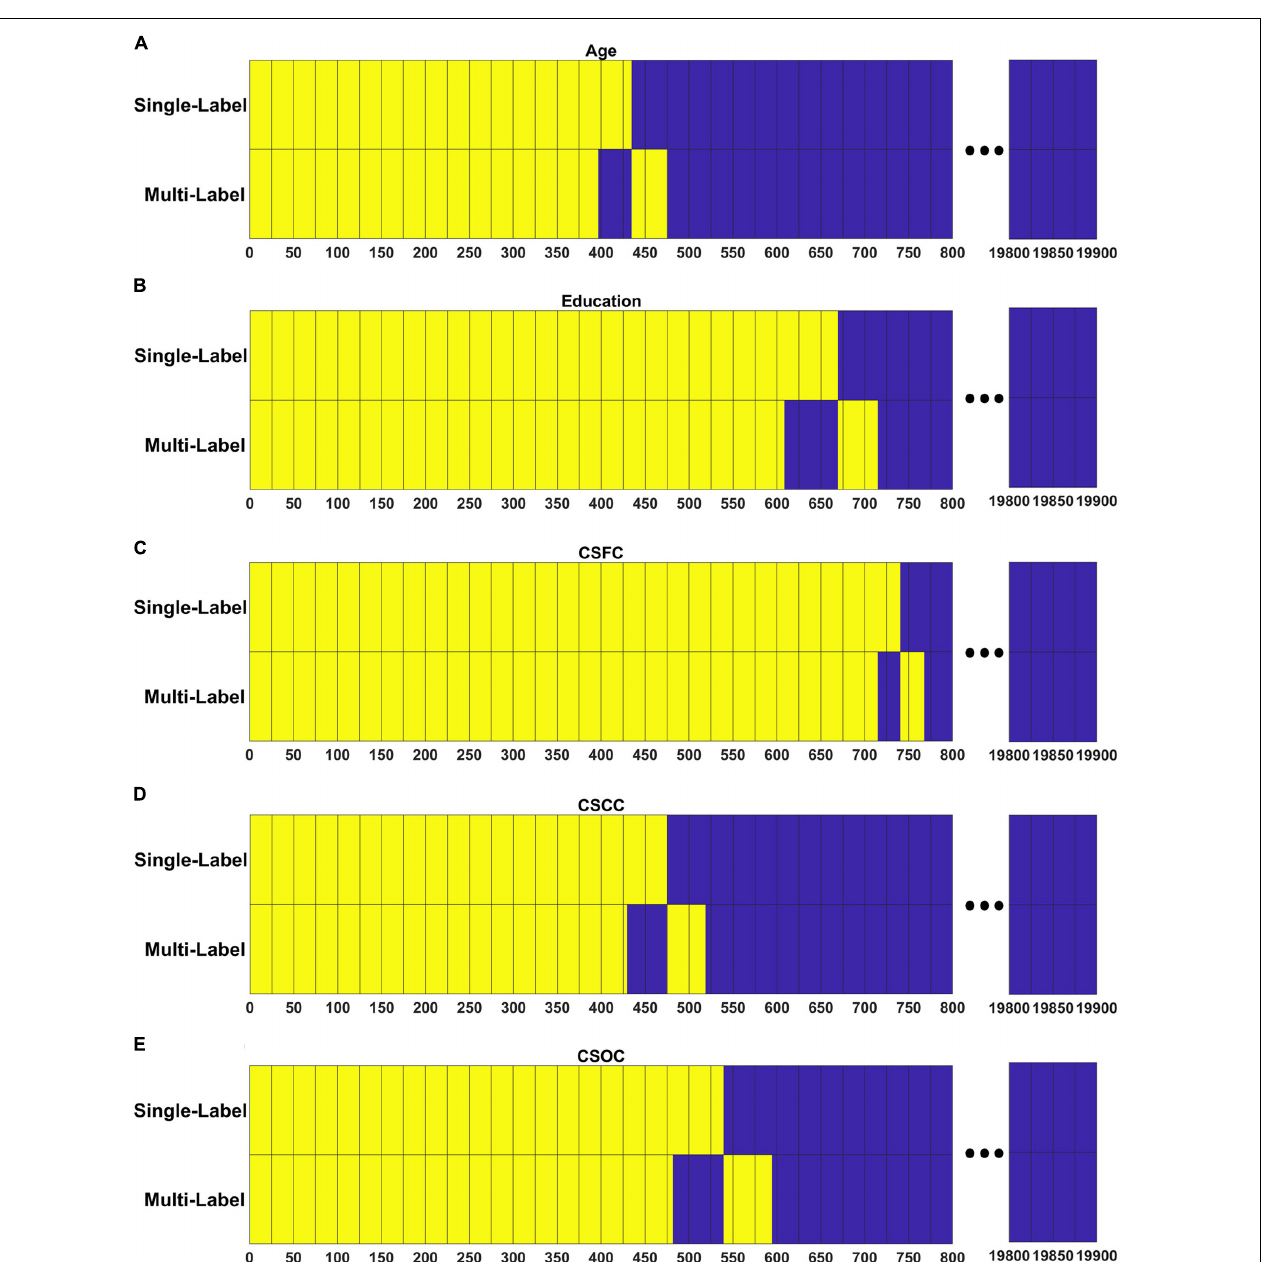
FIGURE 7 | Resting state functional connections made significant contributions shared across the PLSR models established in the first and fourth set of estimations. For each model, RSFCs made significant contributions are marked with yellow, RSFCs made non-significant contributions are marked with blue, and common features between the two models are vertically aligned. Respectively, among the 437, 653, 741, 473, and 536 RSFCs that made significant contributions to the simultaneous estimations of (A) age, (B) education, (C) CSFC, (D) CSCC, and (E) CSOC, 396, 608, 714, 429, and 481 were in common between the multi- and single-label